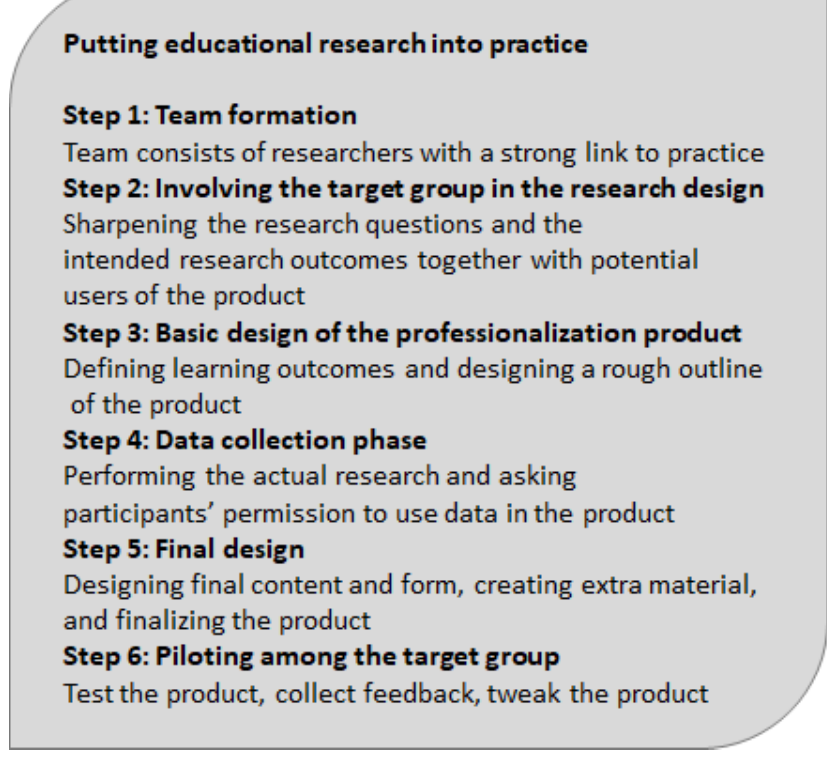
Figure 2: Summary of the roadmap for the translation of educational research into